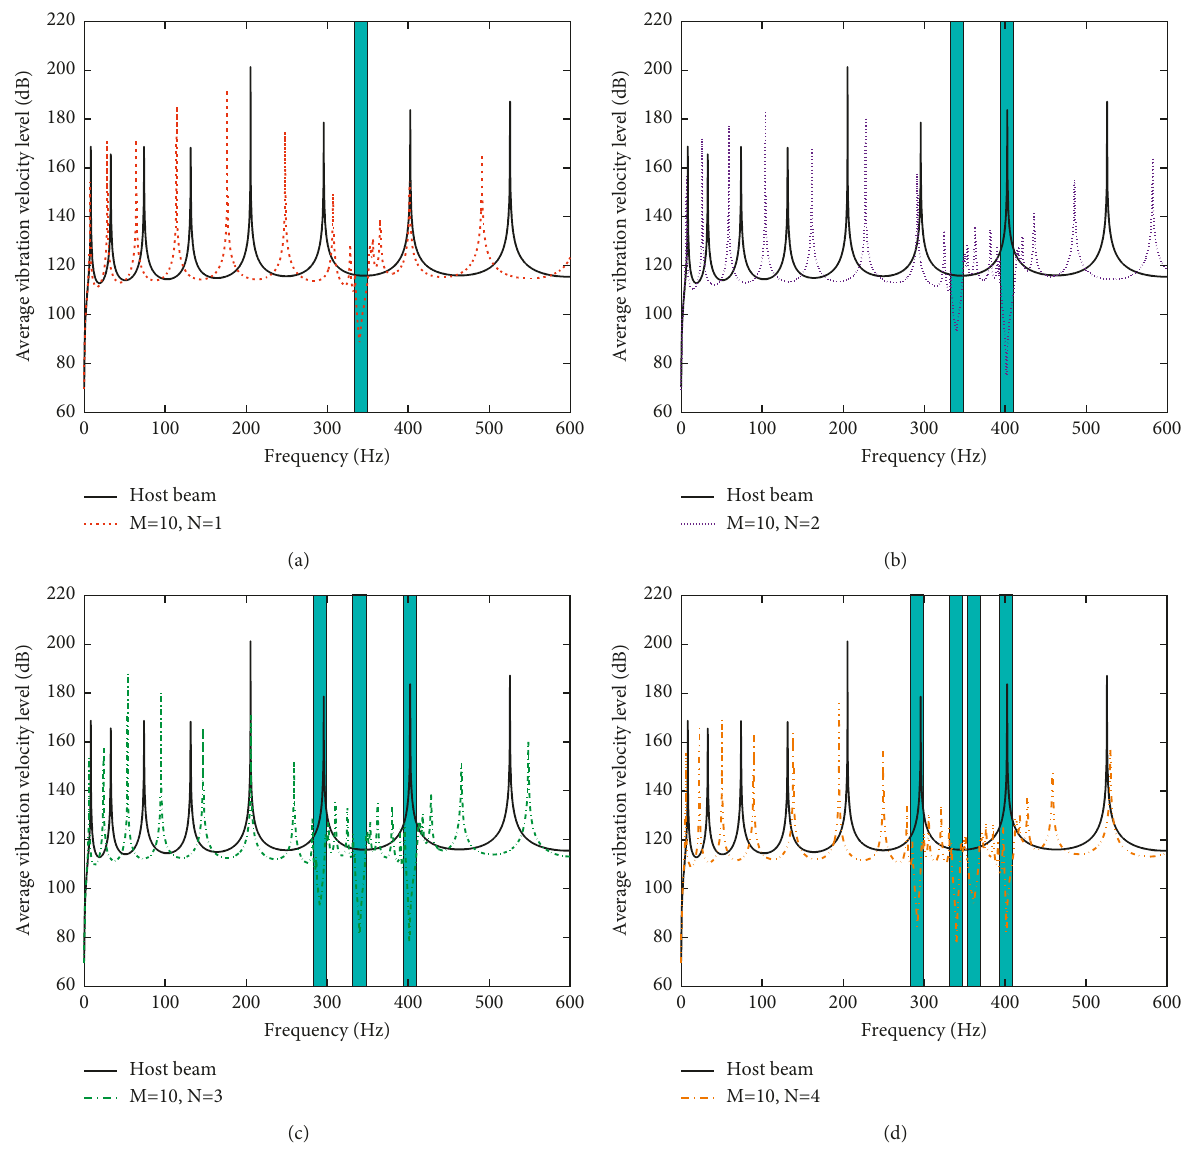
Figure 13: The average velocity response of the finite locally resonant beam with a minimum number of different types of units.